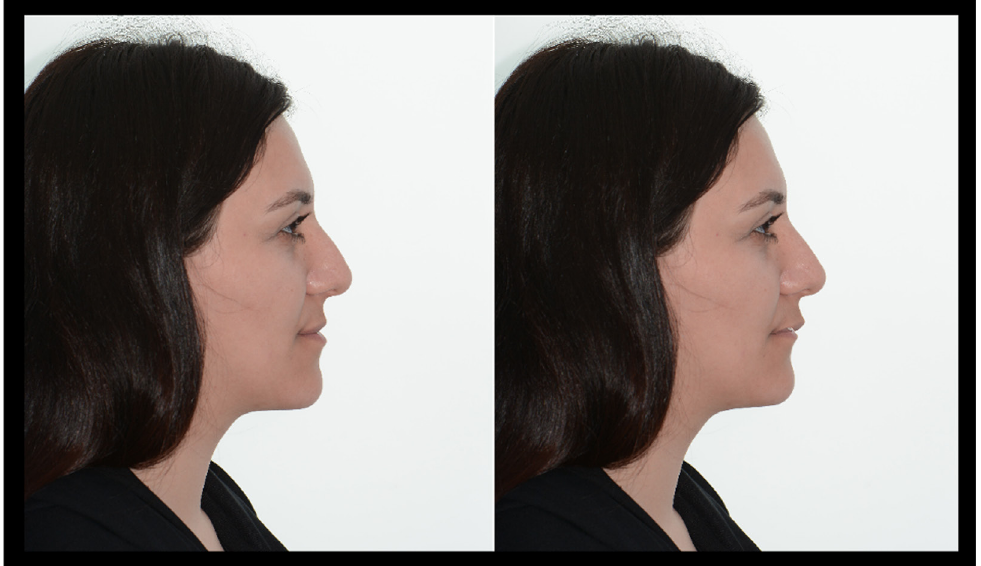
Figure 5. Soft tissue simulation based on the surgical plan.